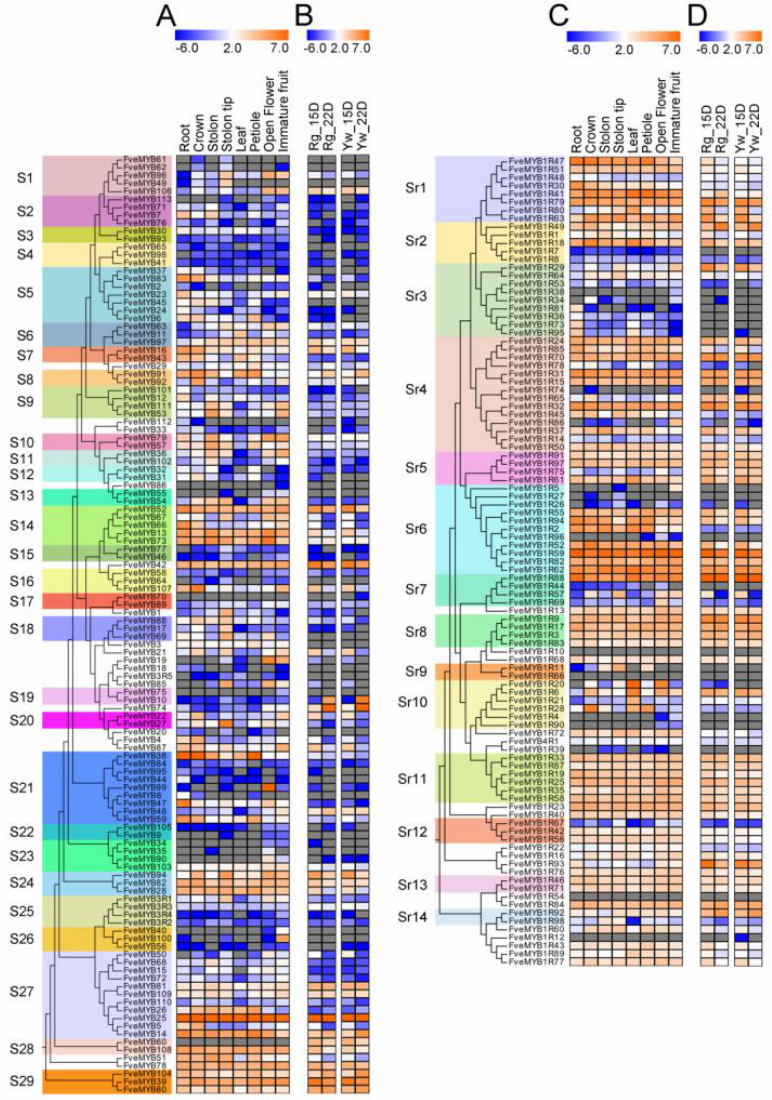
Figure 6. Expression pattern of FveMYB genes in various organs of woodland strawberry. ( A , C ) Expression pattern of 2R-MYB and 3R-MYB, 1R-MYB, and 4R-MYB genes in the root, crown, sto- lon, stolon tip, leaf, petiole, open flower, and immature fruit of woodland strawberry. ( B , D ) Ex- pression pattern of 2R-MYB and 3R-MYB, 1R-MYB and 4R-MYB genes in the immature and rip- ening fruit of two woodland strawberry varieties “Ruegen” and “Yellow Wonder”. The transcrip- tion data were downloaded from Li et al., (2019) [38]. FPKM values in ( A , C ) were located in Sup- plementary Table S2. RPKM values in ( B , D ) were located in Supplementary S3. The heat map showed log2